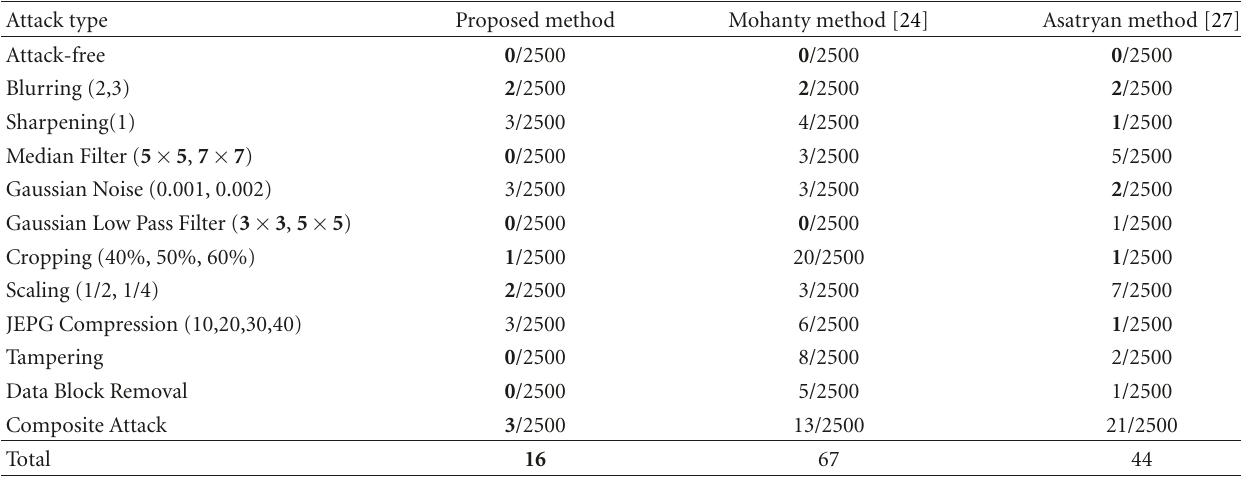
Table 5: Error rates of detecting watermark.